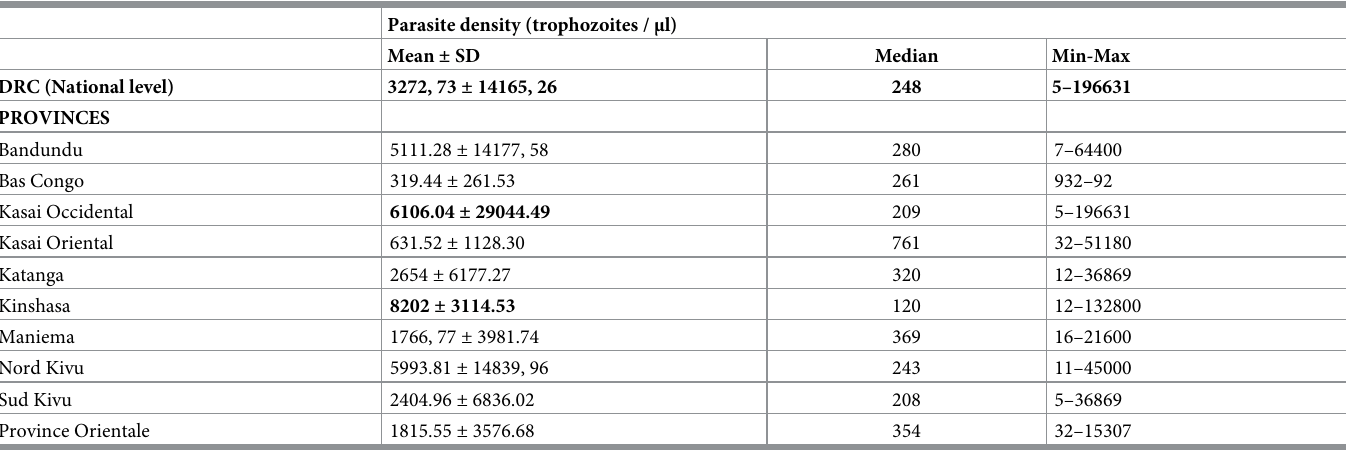
Table 2. Distribution by parasite density.